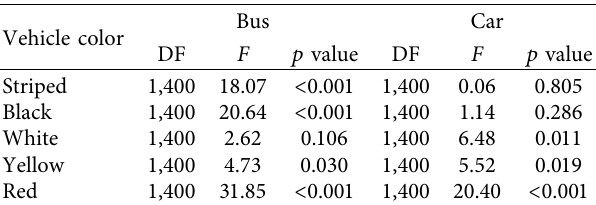
Table 10: Effects of lighting conditions under the rear identifi- cation